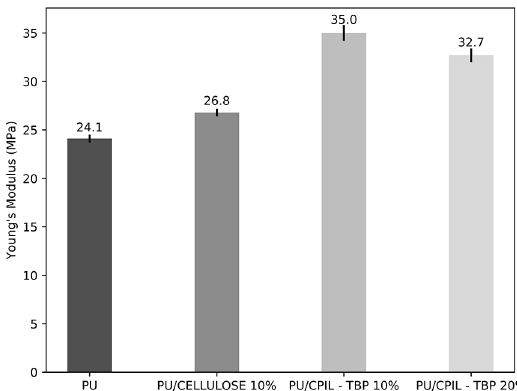
Figure 8. Young moduli of PU and PU composites.